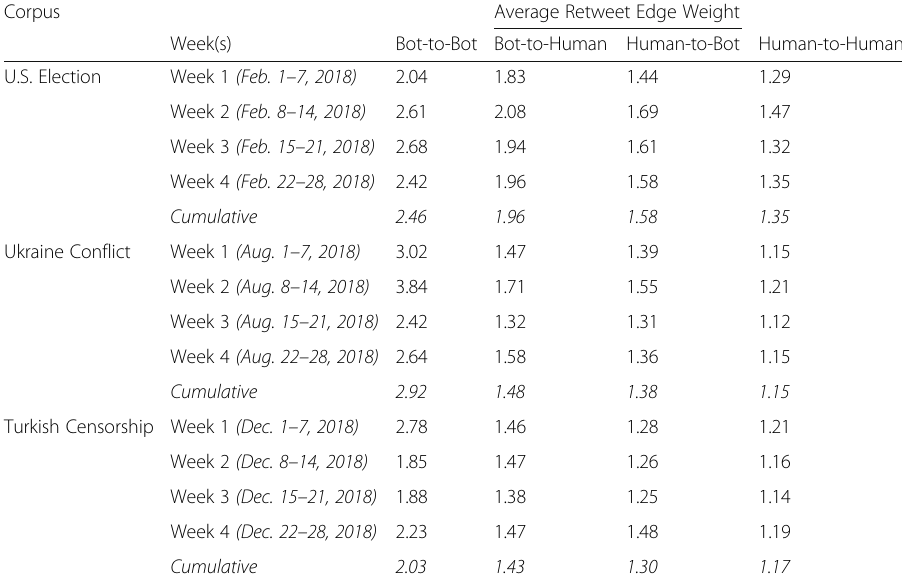
Table 4 Average retweet edge weight for all inter-group and cross-group communications by human and bot users for each OSN conversation Corpus Average Retweet Edge Weight Week(s) Bot-to-Bot Bot-to-Human Human-to-Bot Human-to-Human U.S. Election